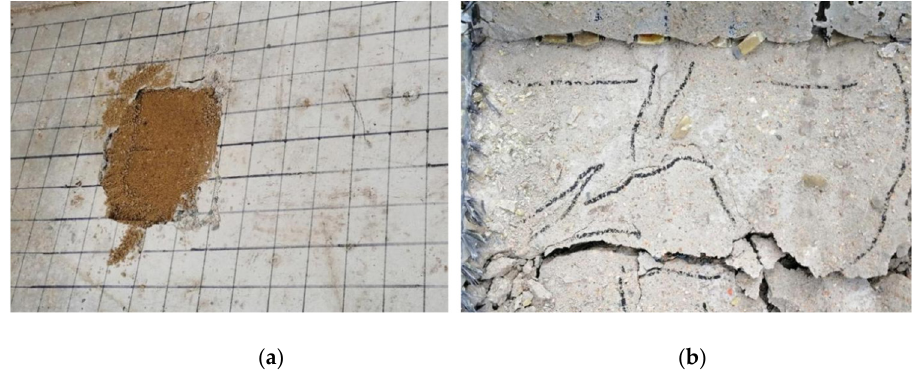
Damage to lower part of bridge deck. ( b )